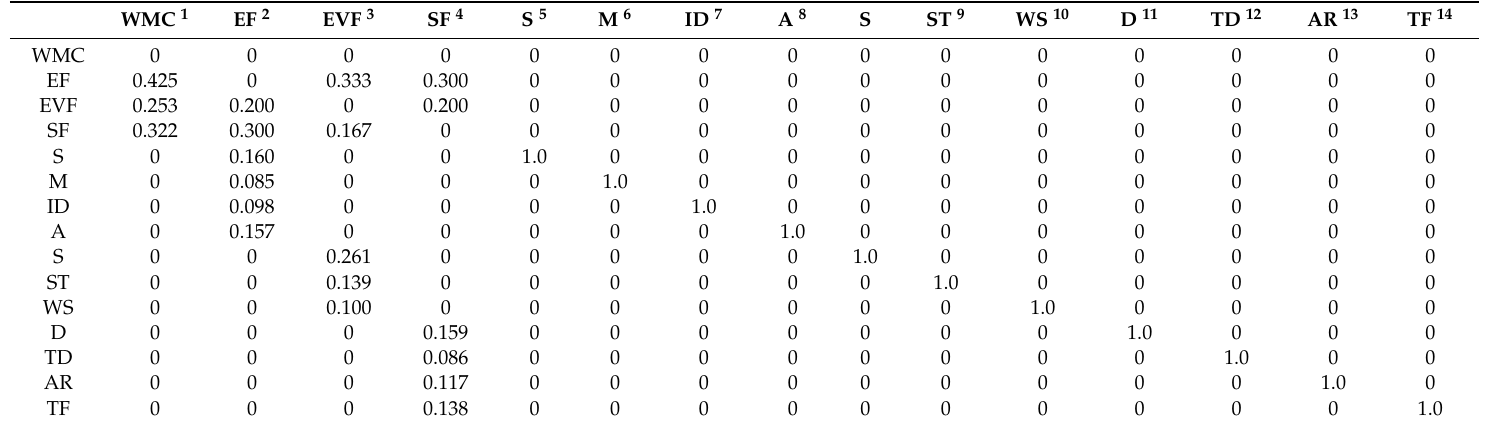
Table A2. Weighted